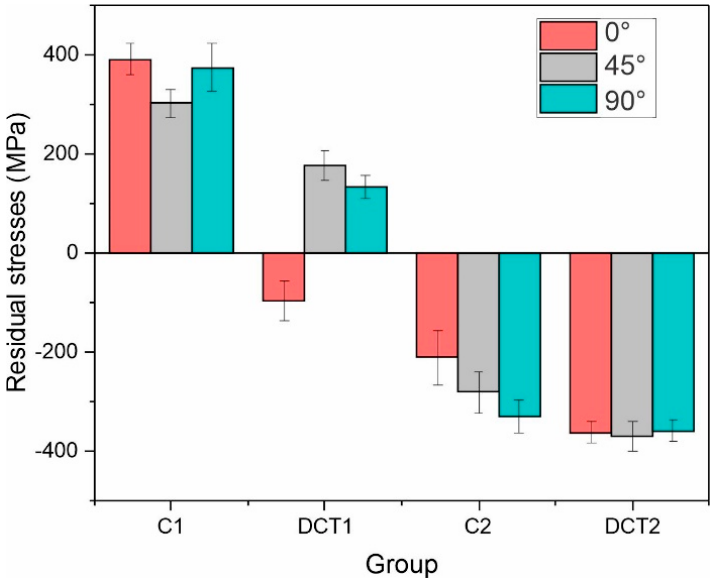
Figure 6. Residual stress measurements for all four heat treatment groups (C1/C2 have conventional solution annealing, and DCT1/DCT2 are deep cryogenically treated). Different colors define the different orientations of stress measurements.